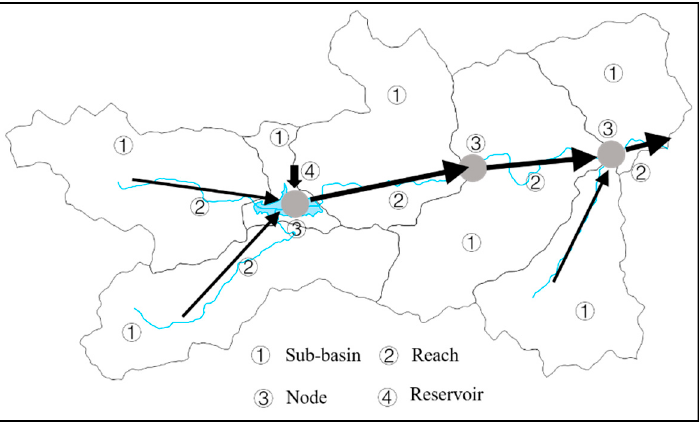
Figure 2. Diagram of model elements and their topological relationships.